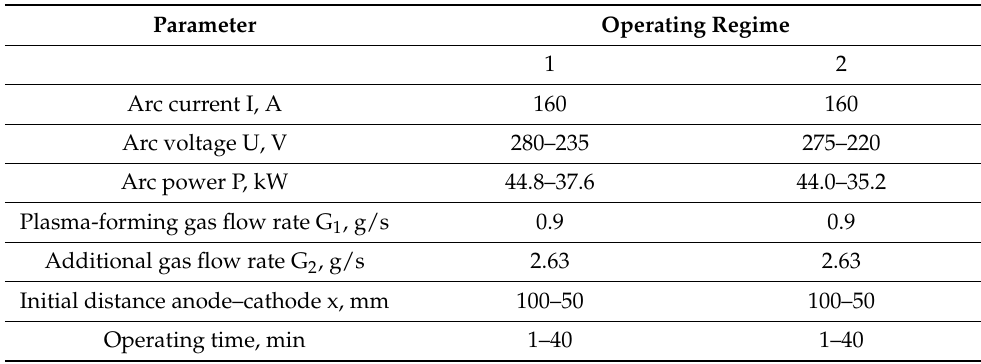
Table 1. Operating parameters of the plasma-chemical reactor. Parameter Operating Regime Arc current I, A